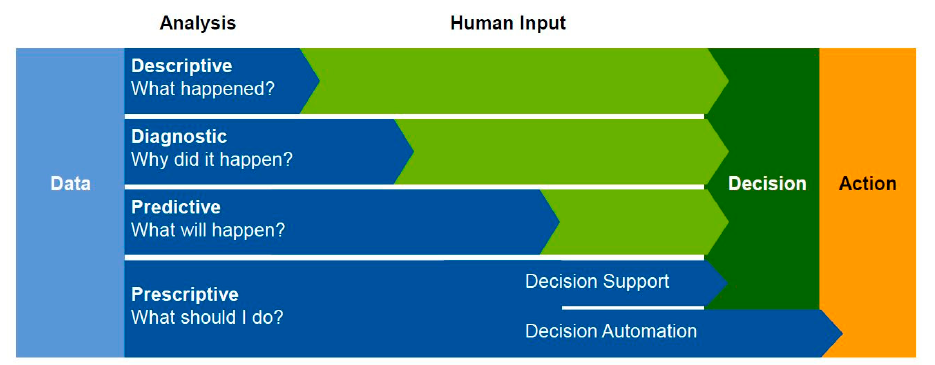
Figure 2. From data to a decision support system (based on [61]).